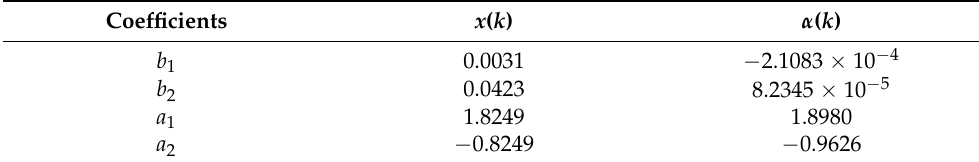
Table 8. Coefficients of the experimental position and sway ARX models.